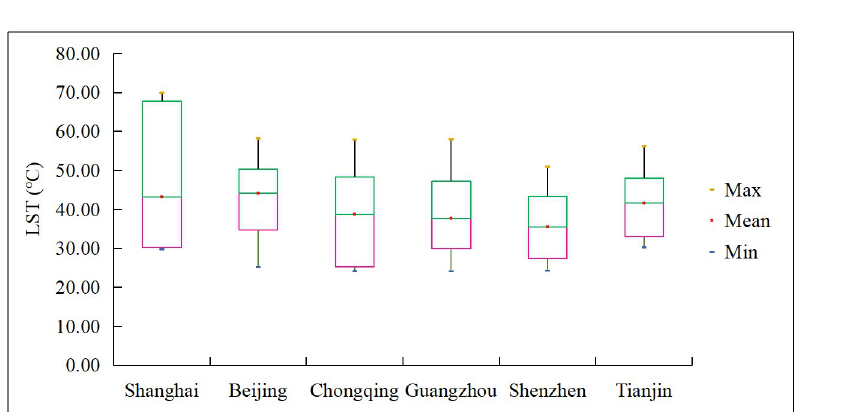
Fig 4. Box plots of LST